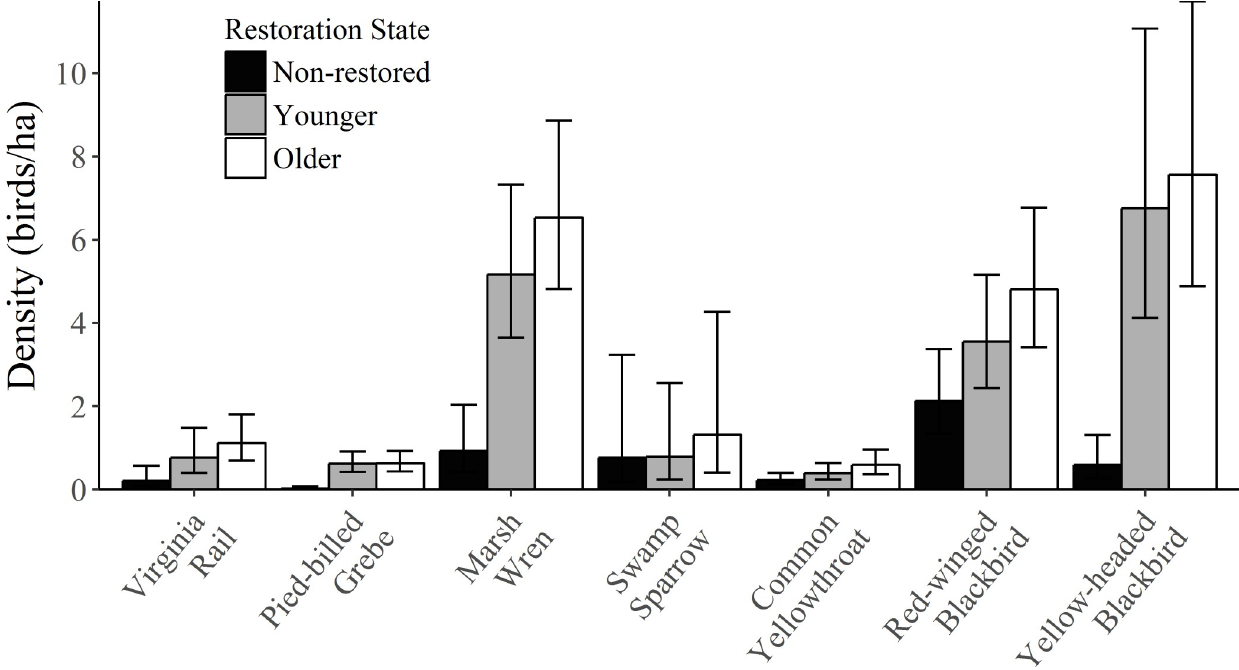
Fig 2. Densities (birds/ha) of breeding marsh birds across shallow lakes surveyed in the Prairie Pothole Region of Iowa, summer 2016 and 2017. Sites are divided into non-restored, younger (1–5 years since restoration), and older (6–11 years since restoration) shallow lakes. Vertical error bars represent 95% confidence